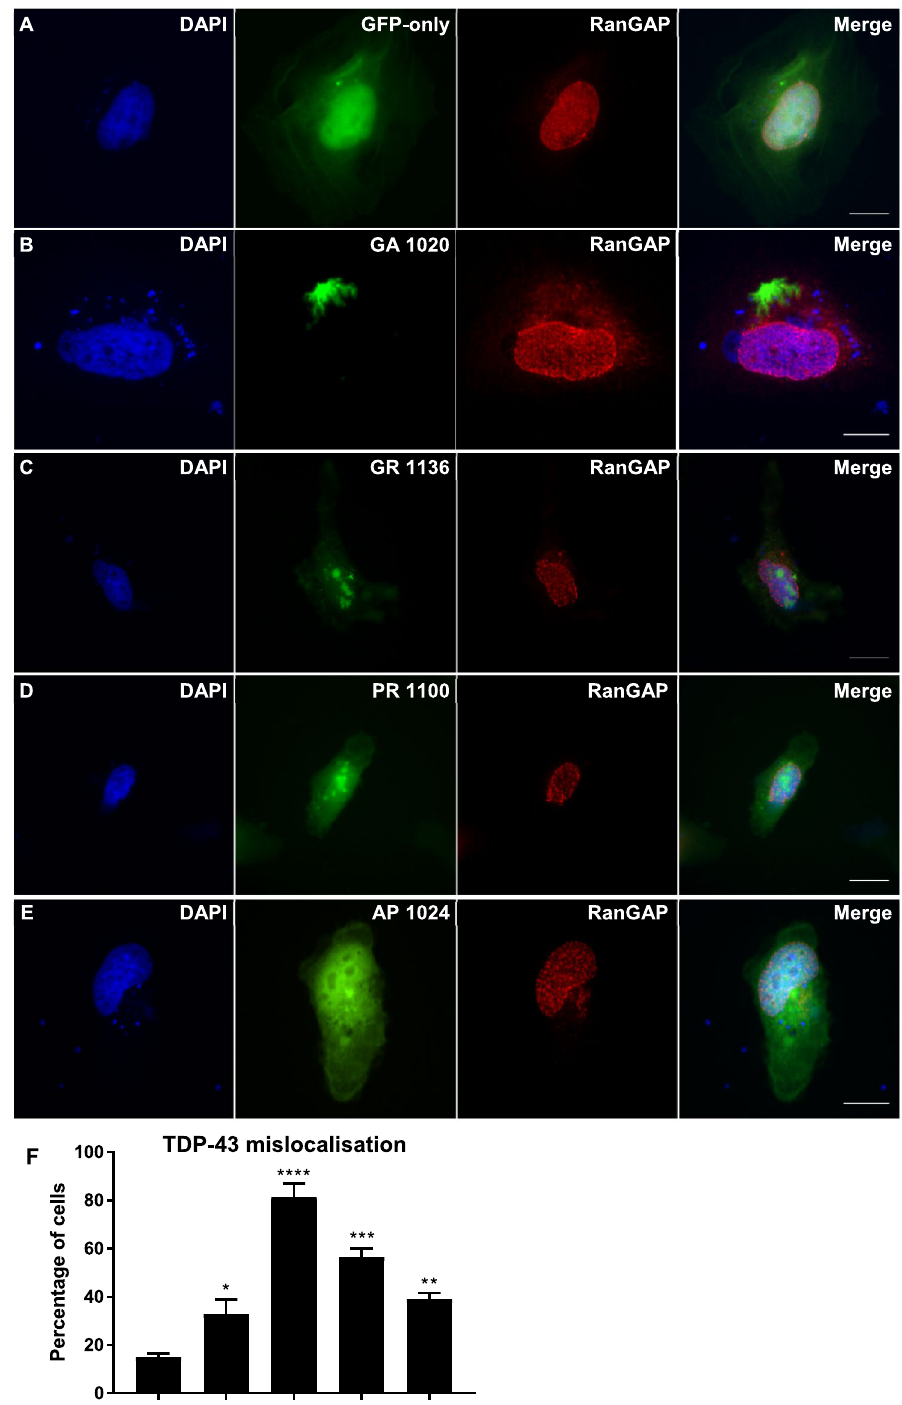
Figure 3. RanGAP formed granular inclusions in cells expressing DPRs. ( A – E ) HeLa cells transfected with GFP-tagged DPR constructs or empty pEGFP-N1 vector as a GFP-only control were fixed and stained 48 h post-transfection. RanGAP (red) is diffusely expressed in the nucleus of GFP-only control cells ( A ) but formed granular inclusions in the nuclei of a proportion of cells expressing DPRs ( B – E ). Scale bars indicate 15 μm. ( F ) Graph shows the percentage of cells exhibiting granular RanGAP inclusions, which was significantly increased by expression of GA 1020 ( P = 0.0483) , GR 1136 ( P < 0.0001), PR 1100 ( P = 0.0002) or AP 1024 ( P = 0.0096). n = 3, with a minimum of 30 cells analysed for each independent replicate. Data was analysed by one-way ANOVA with Dunnett’s multiple comparison test. Error bars indicate